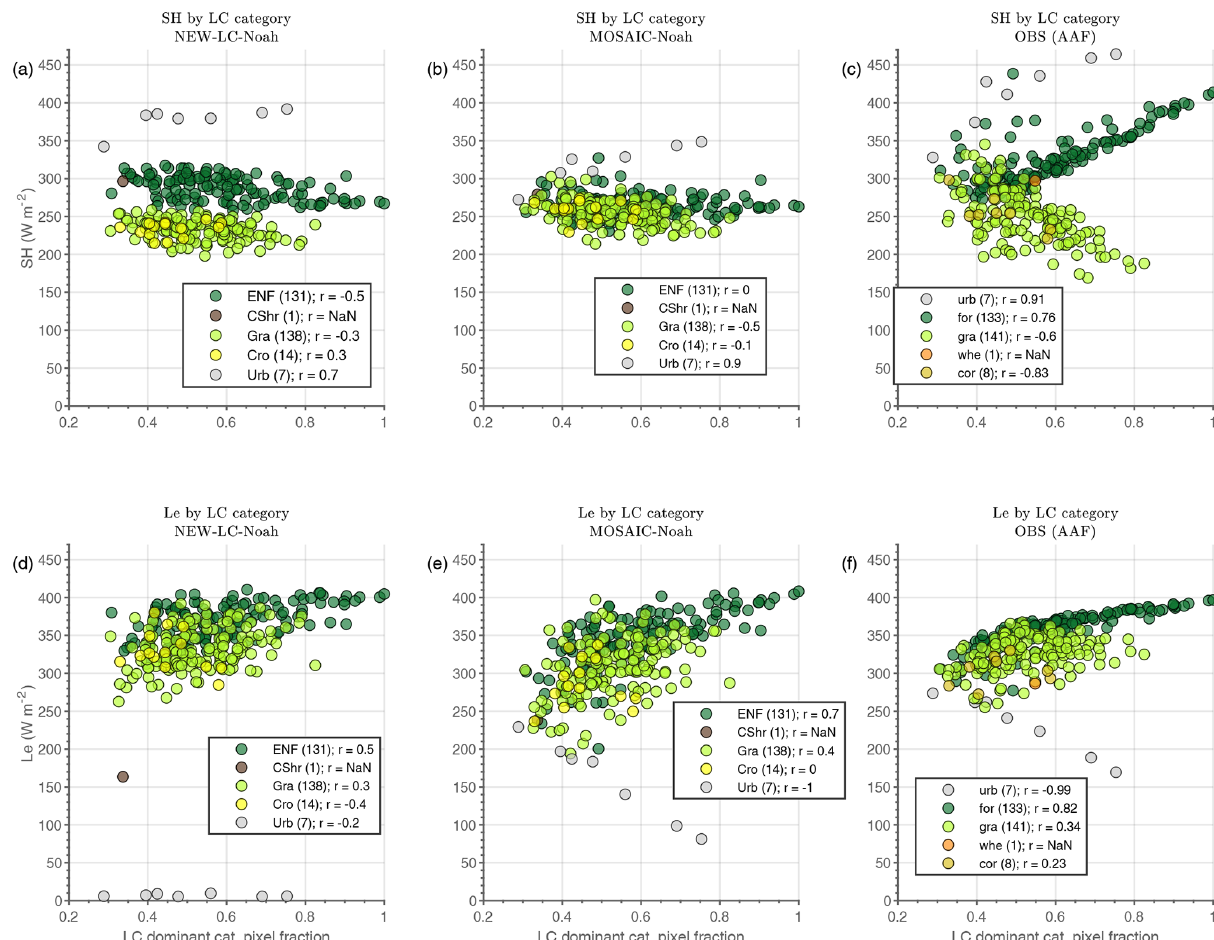
Figure 7. Same as in Fig. 6 but comparing the results from Noah-NEW-LC (using a dominant approach) and from Noah-MOSAIC (using a mosaic approach). Panels (c) and (f) correspond to the area-averaged fluxes (AAFs) from observations, which are considered to be the reference. The correlation between the fluxes and the fraction of coverage of the dominant LC category is included in the legend for each LC category within each pixel, with the number of pixels used in